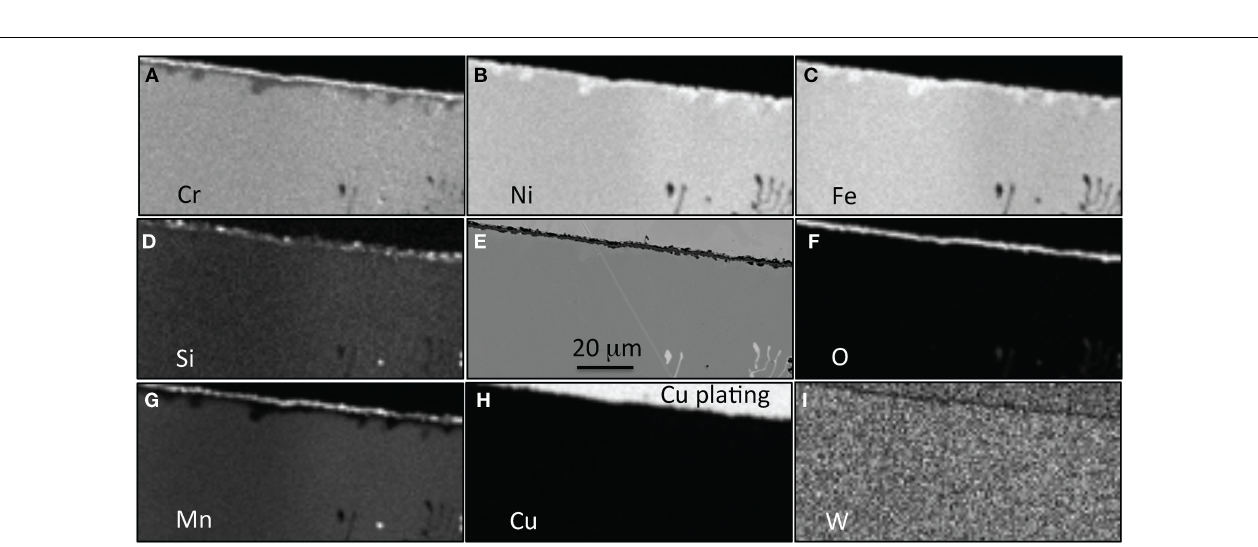
FIGURE 4 | EPMA mapping for alloy CF8CP after exposure for 1000h in air +++ 10% H 2 O at 700°C, (A) Cr, (B) Ni, (C) Fe, (D) Si, (E) SEM picture, (F) O, (G) Mn, (H) Mo, and (I) Nb .